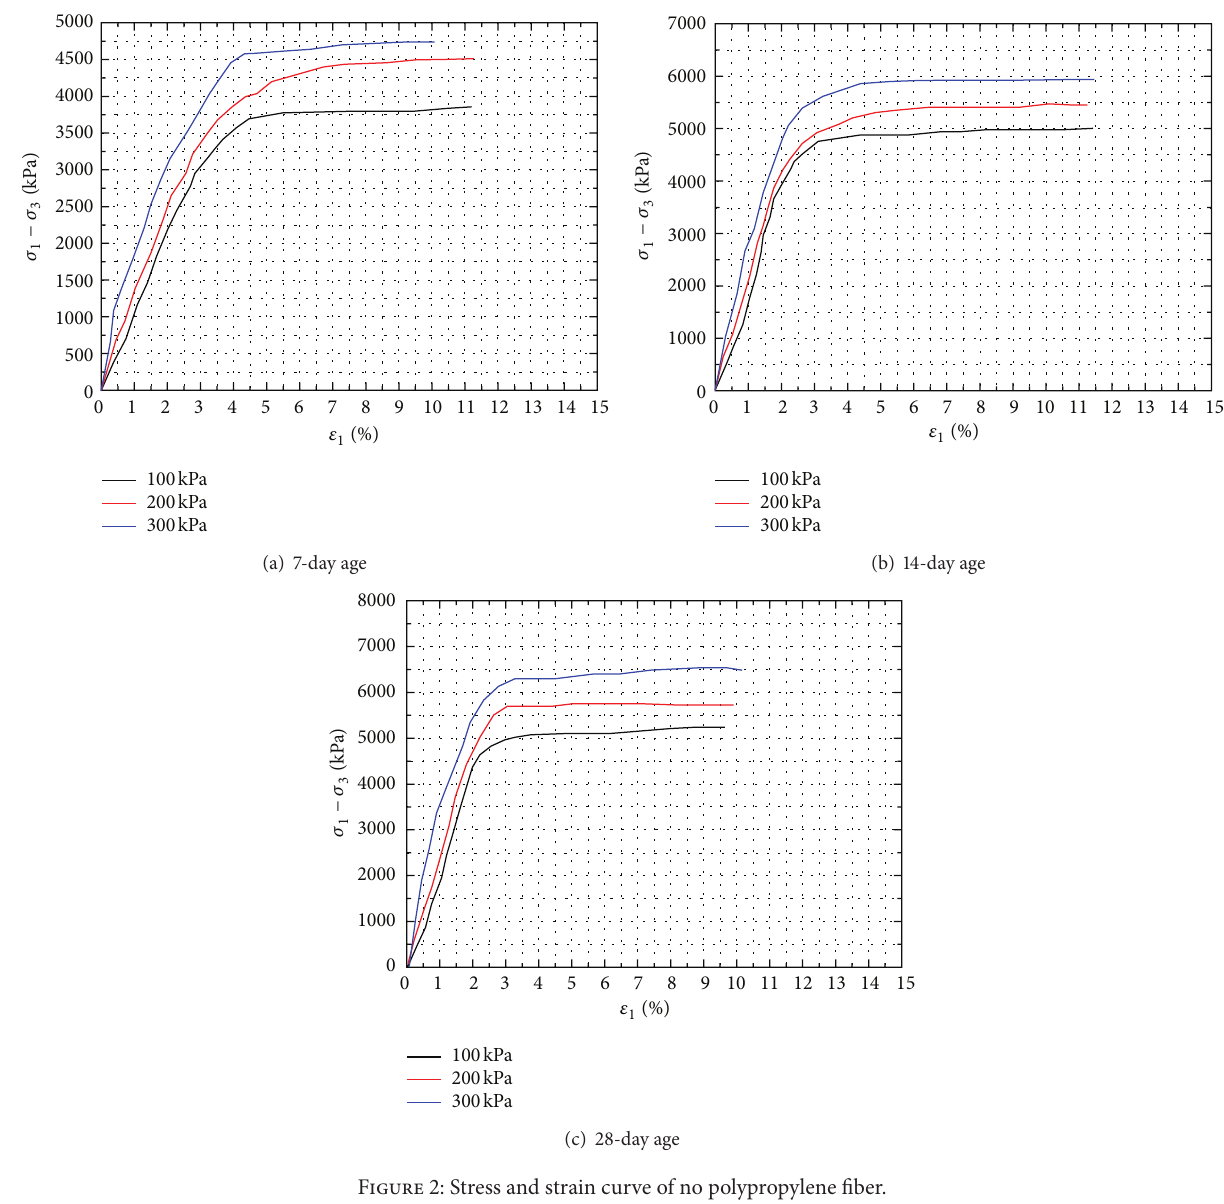
Figure 2: Stress and strain curve of no polypropylene